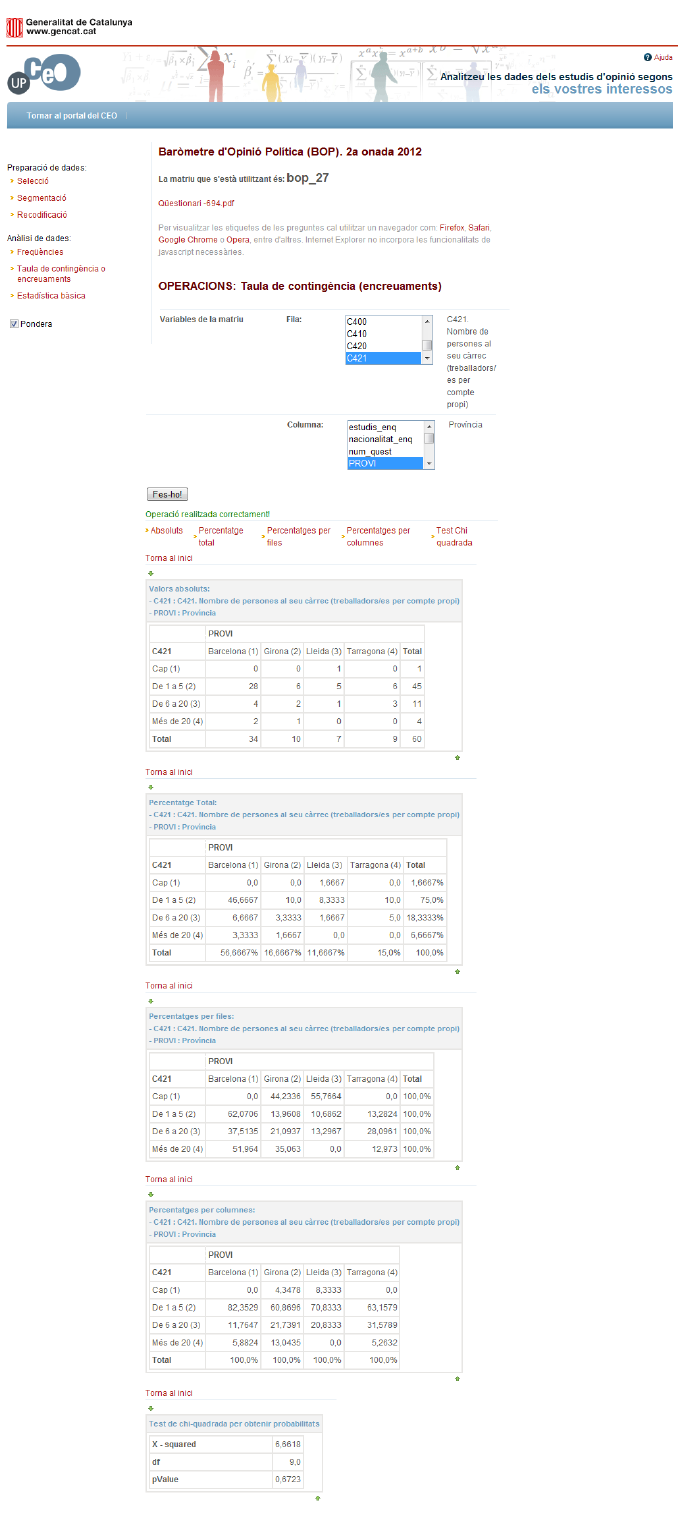
Figure 15. In the Taula de contingencia (encreuaments) , the user obtains a bivariate analysis of contingency tables for two selected variables. The analysis involves several R commands that completely describe the variables involved in the analysis. The user does not need any knowledge of R or its syntax. The user simply needs to select the two variables to be analyzed and the system ensures the correctness of the information presented.